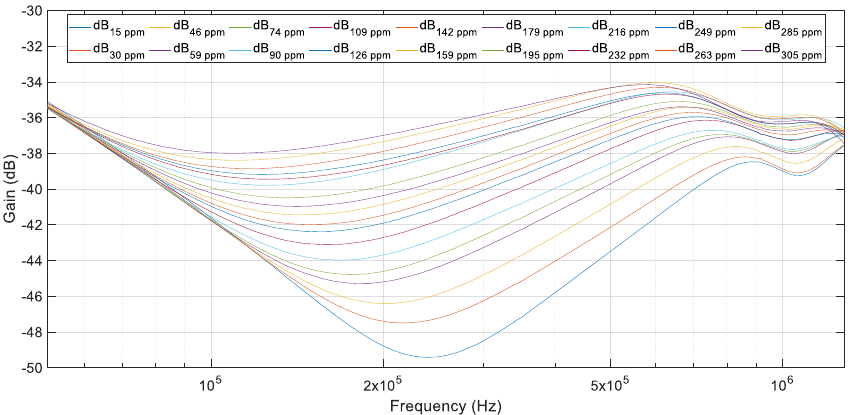
Figure 14. FRA test results from 15 ppm up to 305 ppm of salt in water. Zoom (100 kHz to 500 kHz).